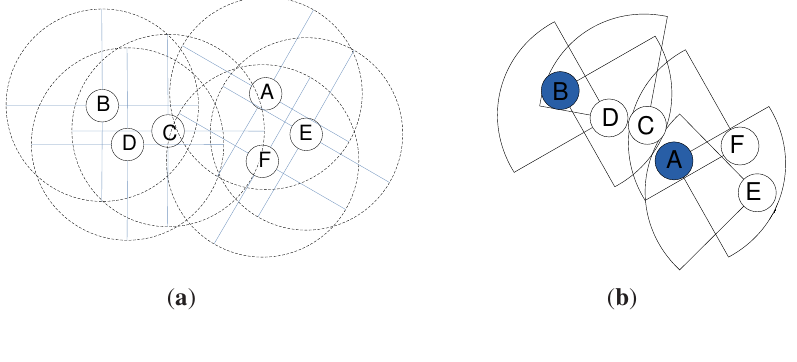
Figure 2. Cluster formation. ( a ) Before cluster formation; ( b ) after cluster